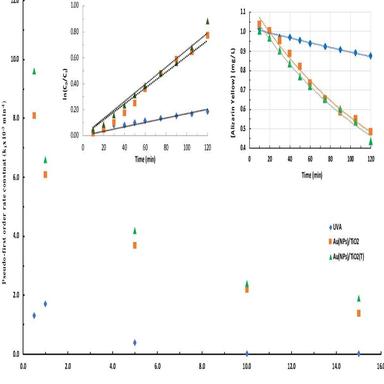
The pseudo-first order rate constant values for various concentrations of Alizarin Yellow for photolytic and photocatalytic operations .